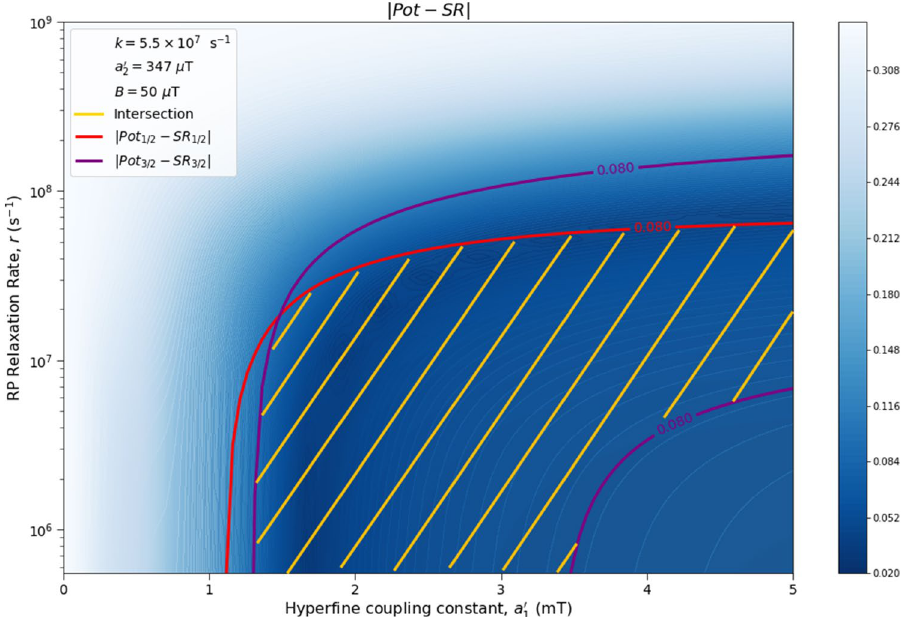
Figure 3. The dependence of the agreement between relative anesthetic potency and singlet yield ratio on changes in the hyperfine coupling constant a ′ 1 and the RP spin-coherence relaxation rate r for a ′ 1 ∈ [ 0, 5000 ] µ T and r ∈ [ 5.0 × 10 5 , 1.0 × 10 9 ] s − 1 , using a ′ 2 = 347 µ T, B = 50 µ T, and k = 5.5 × 10 7 s − 1 . The singlet yield ratio SR is calculated using a 1 = (γ n / | γ 129 Xe | )γ e a ′ 1 , where the magnitude of the isotopic nuclear gyromagnetic correction factor, (γ n / | γ 129 Xe | ) , is normalized for 129 Xe. The model can explain the experimentally derived 6 relative anesthetic potency of xenon where ( | Pot 1 / 2 − SR 1 / 2 | ≤ 0.08 ) and ( | Pot 3 / 2 − SR 3 / 2 | ≤ 0.08 ) intersect, shaded in